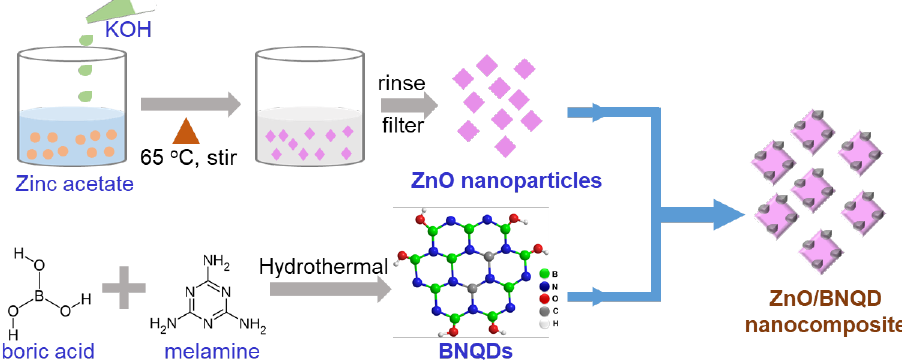
Figure 1. Schematic of the synthesis of ZnO/BNQD nanocomposites.